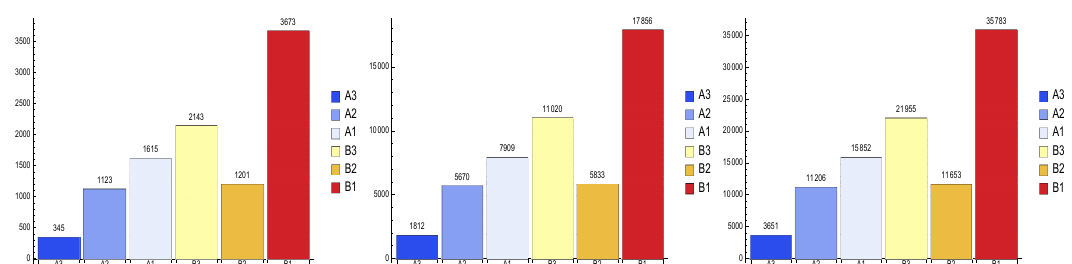
Figure 6. Classification of the lending portfolio with 100 new assets added. ( Left ): when the size is 10,000. ( Center ): when the size is 50,000. ( Right ): when the size is